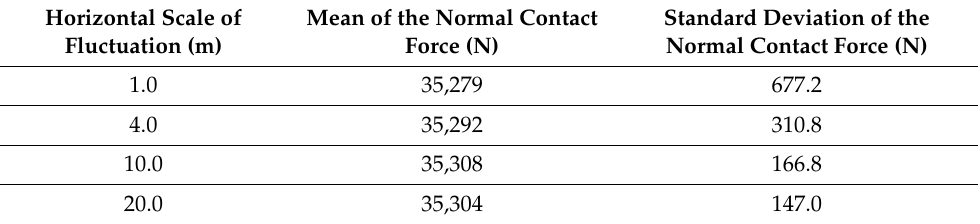
Figure 17. PDFs ( a ) and CDFs ( b ) of the normal contact force at the point A of the elastic block when the horizontal scales of fluctuation are 1.0 m, 4.0 m, 10.0 m and 20.0 m. Table 1. Mean and standard deviation of the normal contact force for different horizontal scales of fluctuation.